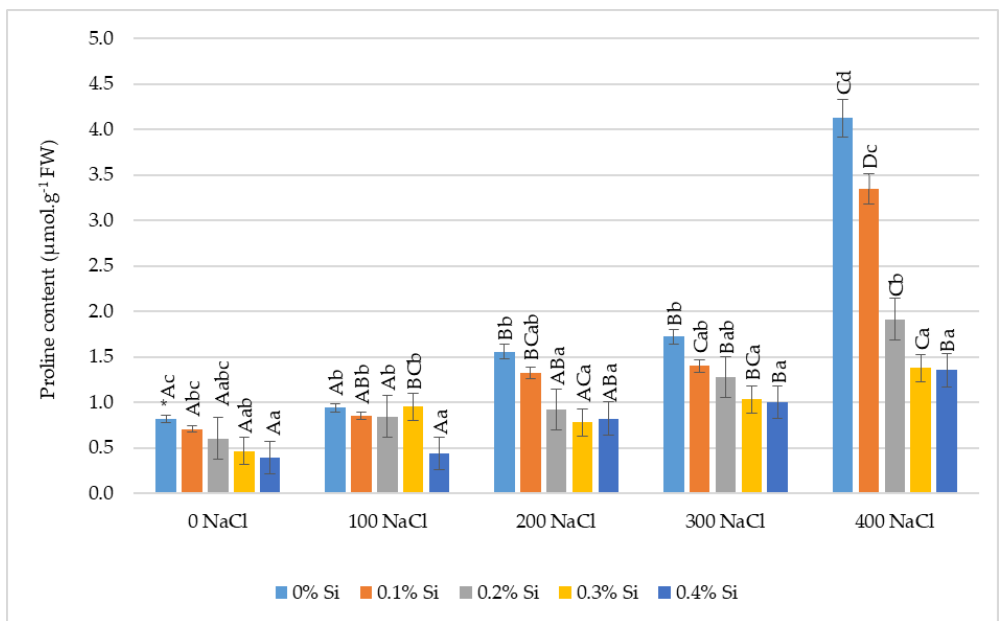
Figure 5. The effect of Si on the free proline content in maize leaves cultivated in varying salinity conditions. * Capital letters indicate significant differences between the means for soil salinity at the same doses of Si, and lowercase letters represent the mean significant differences between the doses of Si at the same salinity ( p = 0.05).